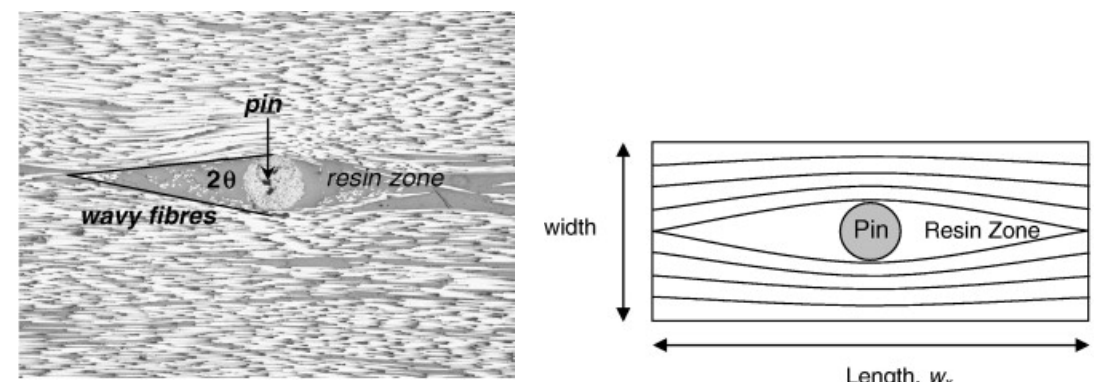
Figure 3. Region of wavy fibers and resin-rich zones at a z-Pin [1].